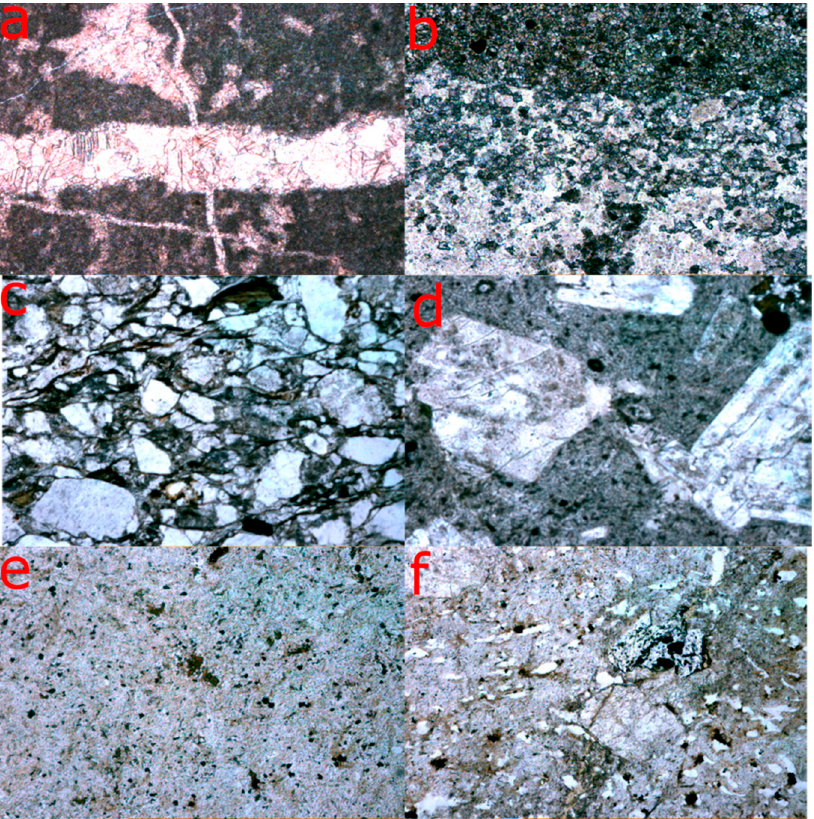
Figure 4. Microphotographs of thin sections for main determined lithotypes in Samobor location: ( a ) limestone, ( b ) dolomite; ( c ) sandstone (greywacke); ( d ) effusive magmatic; ( e ) tuff; ( f ) chert. The width of the microphotographs is 1.7 mm.